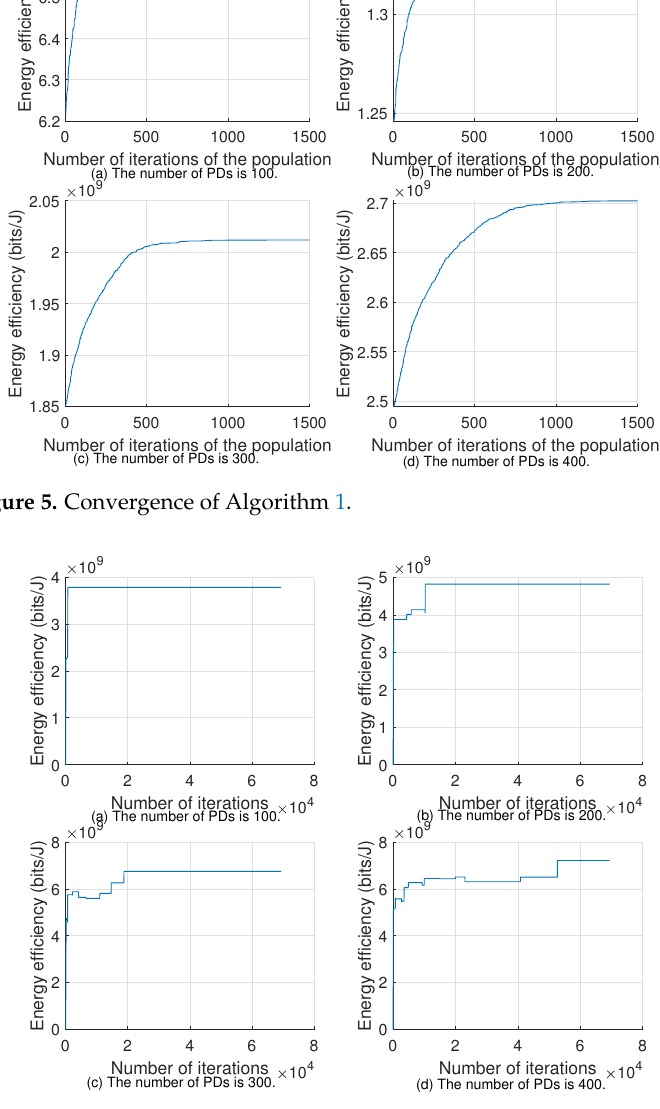
Figure 6. Convergence of Algorithm